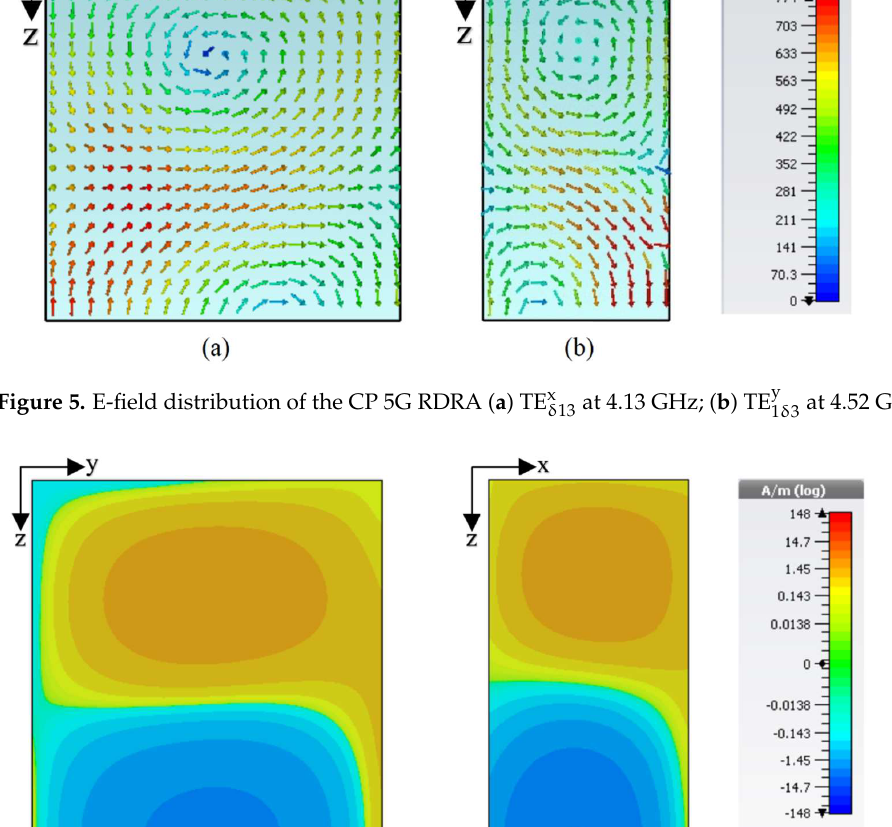
Figure 6. H-field distribution of the CP 5G RDRA ( a ) TE (cid:2964)(cid:2869)(cid:2871)(cid:2934) at 4.13 GHz; ( b ) TE (cid:2869)(cid:2964)(cid:2871)(cid:2935) at 4.52 GHz.